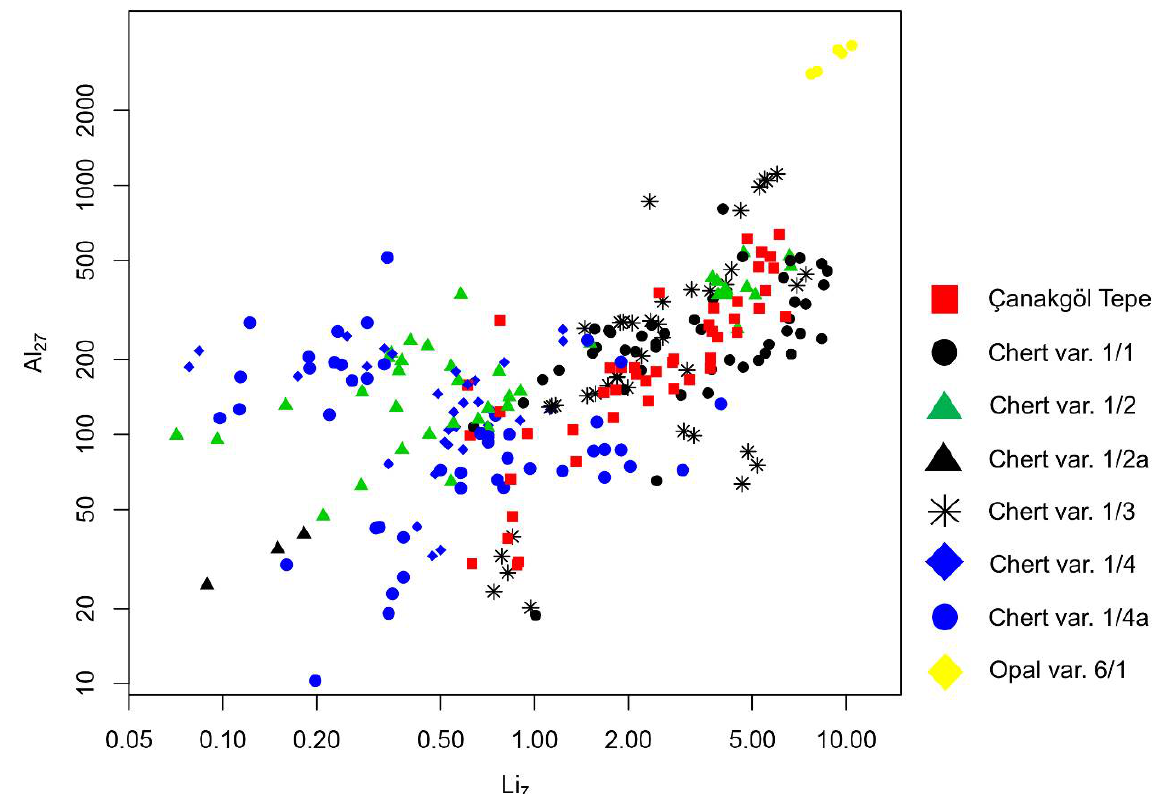
Figure 4. Bivariate Al-Li-scatter plot of the analysed chert samples (graphic by M.